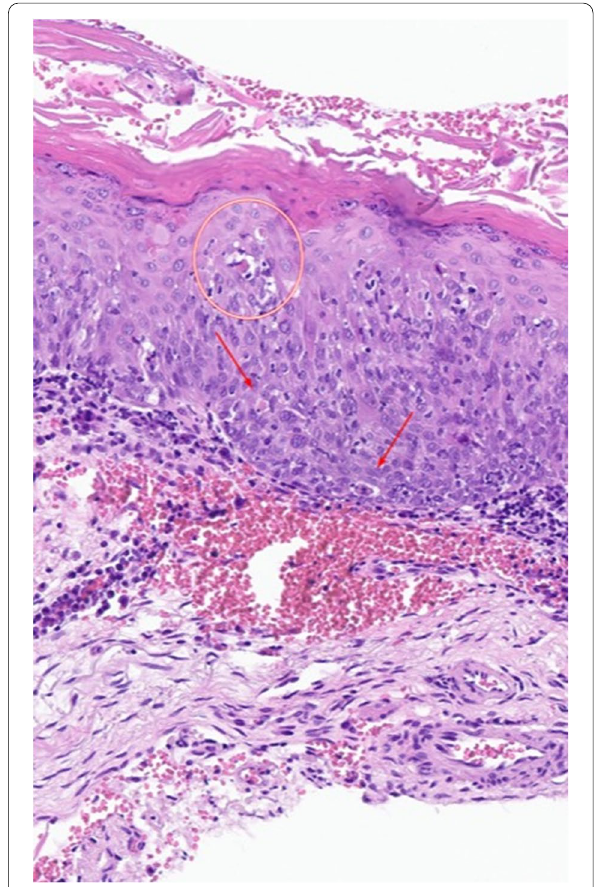
Fig. 2 Histopathological findings photomicrograph showing rounded, eosinophilic cytoid body characteristic of lichen